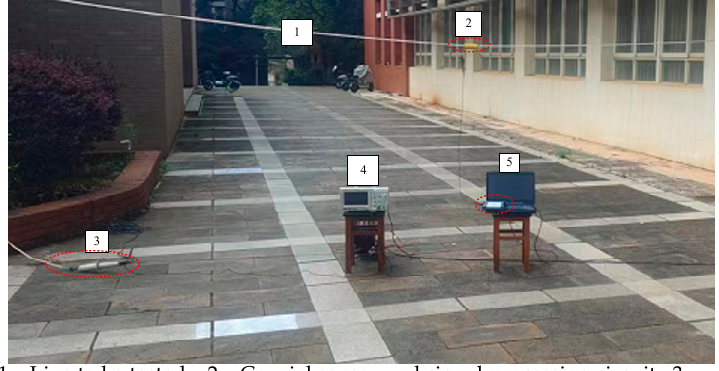
Figure 16. Schematic diagram of the sensor high-voltage performance test experiment.